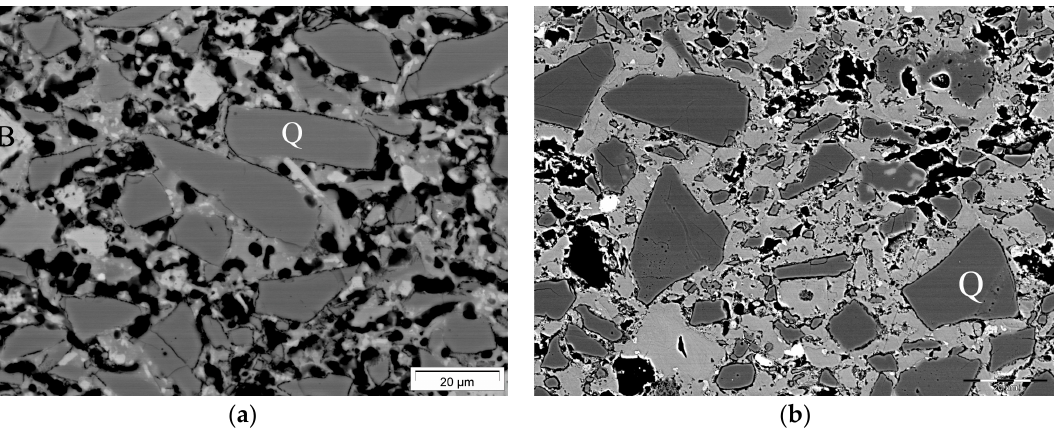
Figure 16. SEM-BSE image of Swiss CaO-rich white earthenware . ( a ) The body of the Kilchberg-Schooren sample SH 26 shows angular quartzes (Q, dark grey), some CaO-rich matrix patches (medium grey), bone fragments (B, whitish) and a high porosity (black voids); ( b ) The quartzes (Q) in the Matzendorf sample BER 15 are somewhat smaller and are embedded in an abundant matrix. Very few bone fragments can be detected and the porosity is significantly lower compared to ( a ) [19]. Scale as in ( a ).